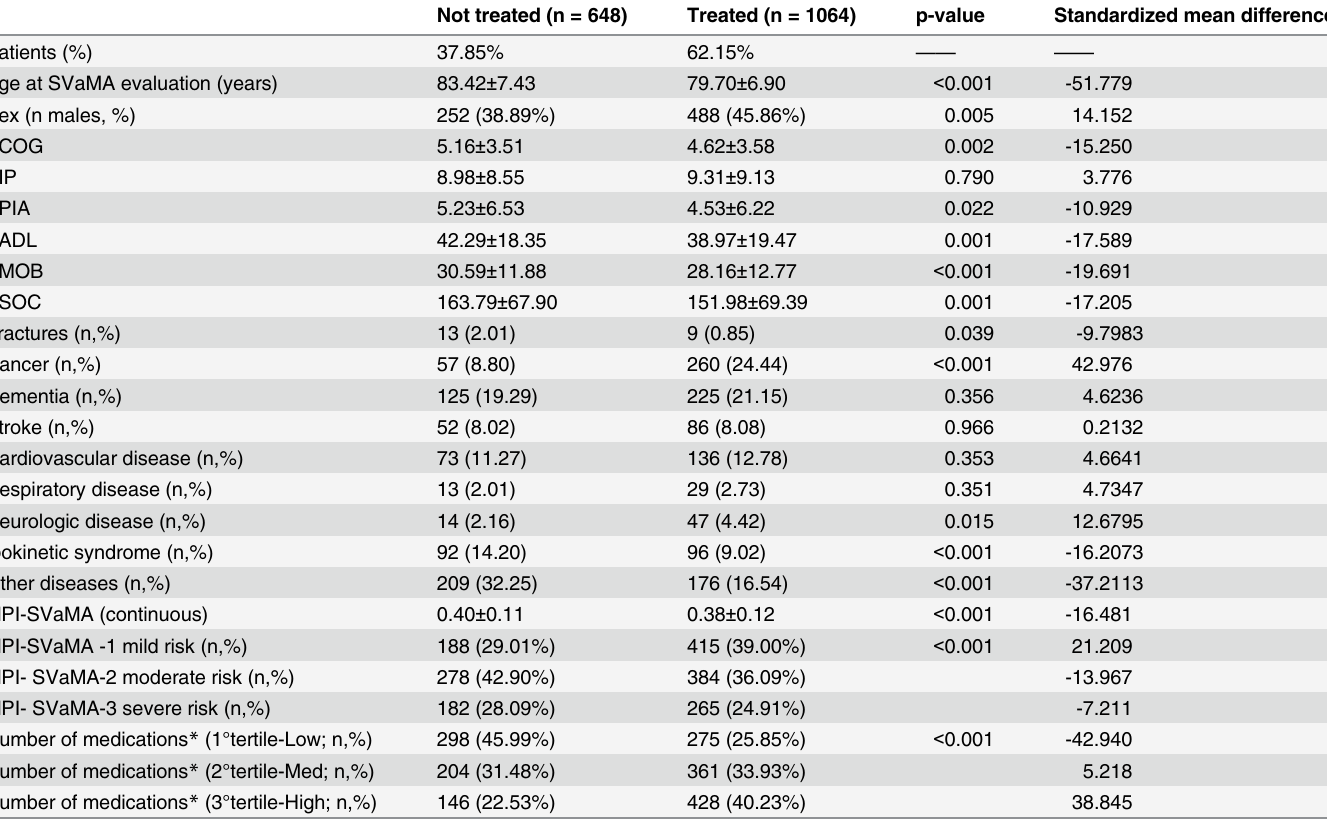
Table 2. Pre-matching baseline characteristics of community-dwelling older patients with diabetes mellitus according to statin